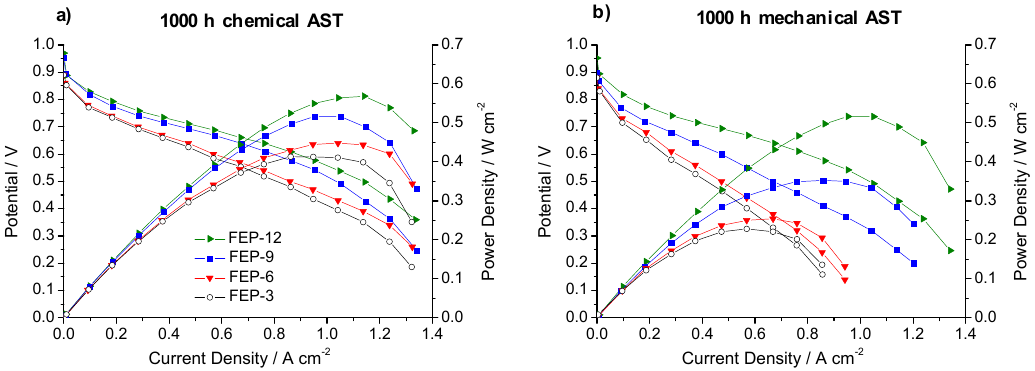
Figure 6. Polarization and power density curves, obtained upon 1000 h of: chemical ( a ) and mechanical ( b ) accelerated stress tests (AST) for FEP-based GDMs.